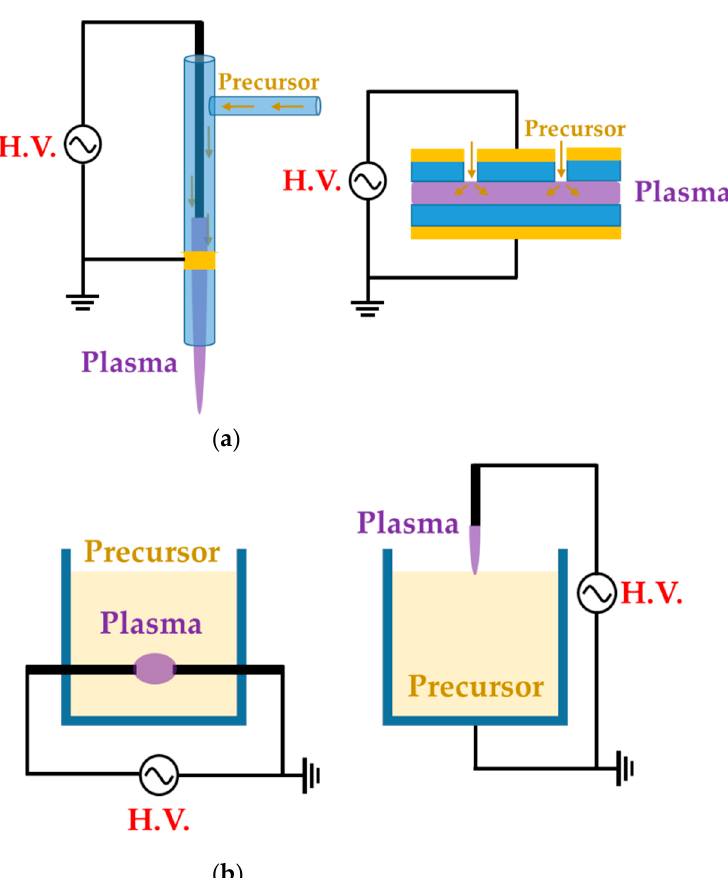
Figure 1. Representative configuration of ( a ) gas/aerosol-through-plasma (GATP) methods (left: jet type, right: dielectric-barrier discharge (DBD) type) and ( b ) solution plasma methods (left: in-solution plasma, right: on-solution plasma).